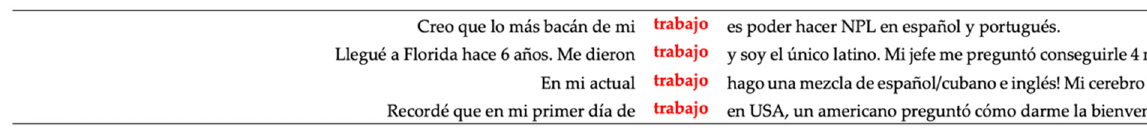
Figure 3. Concordance lines for job that indicate negative attitudes on the status dimension.